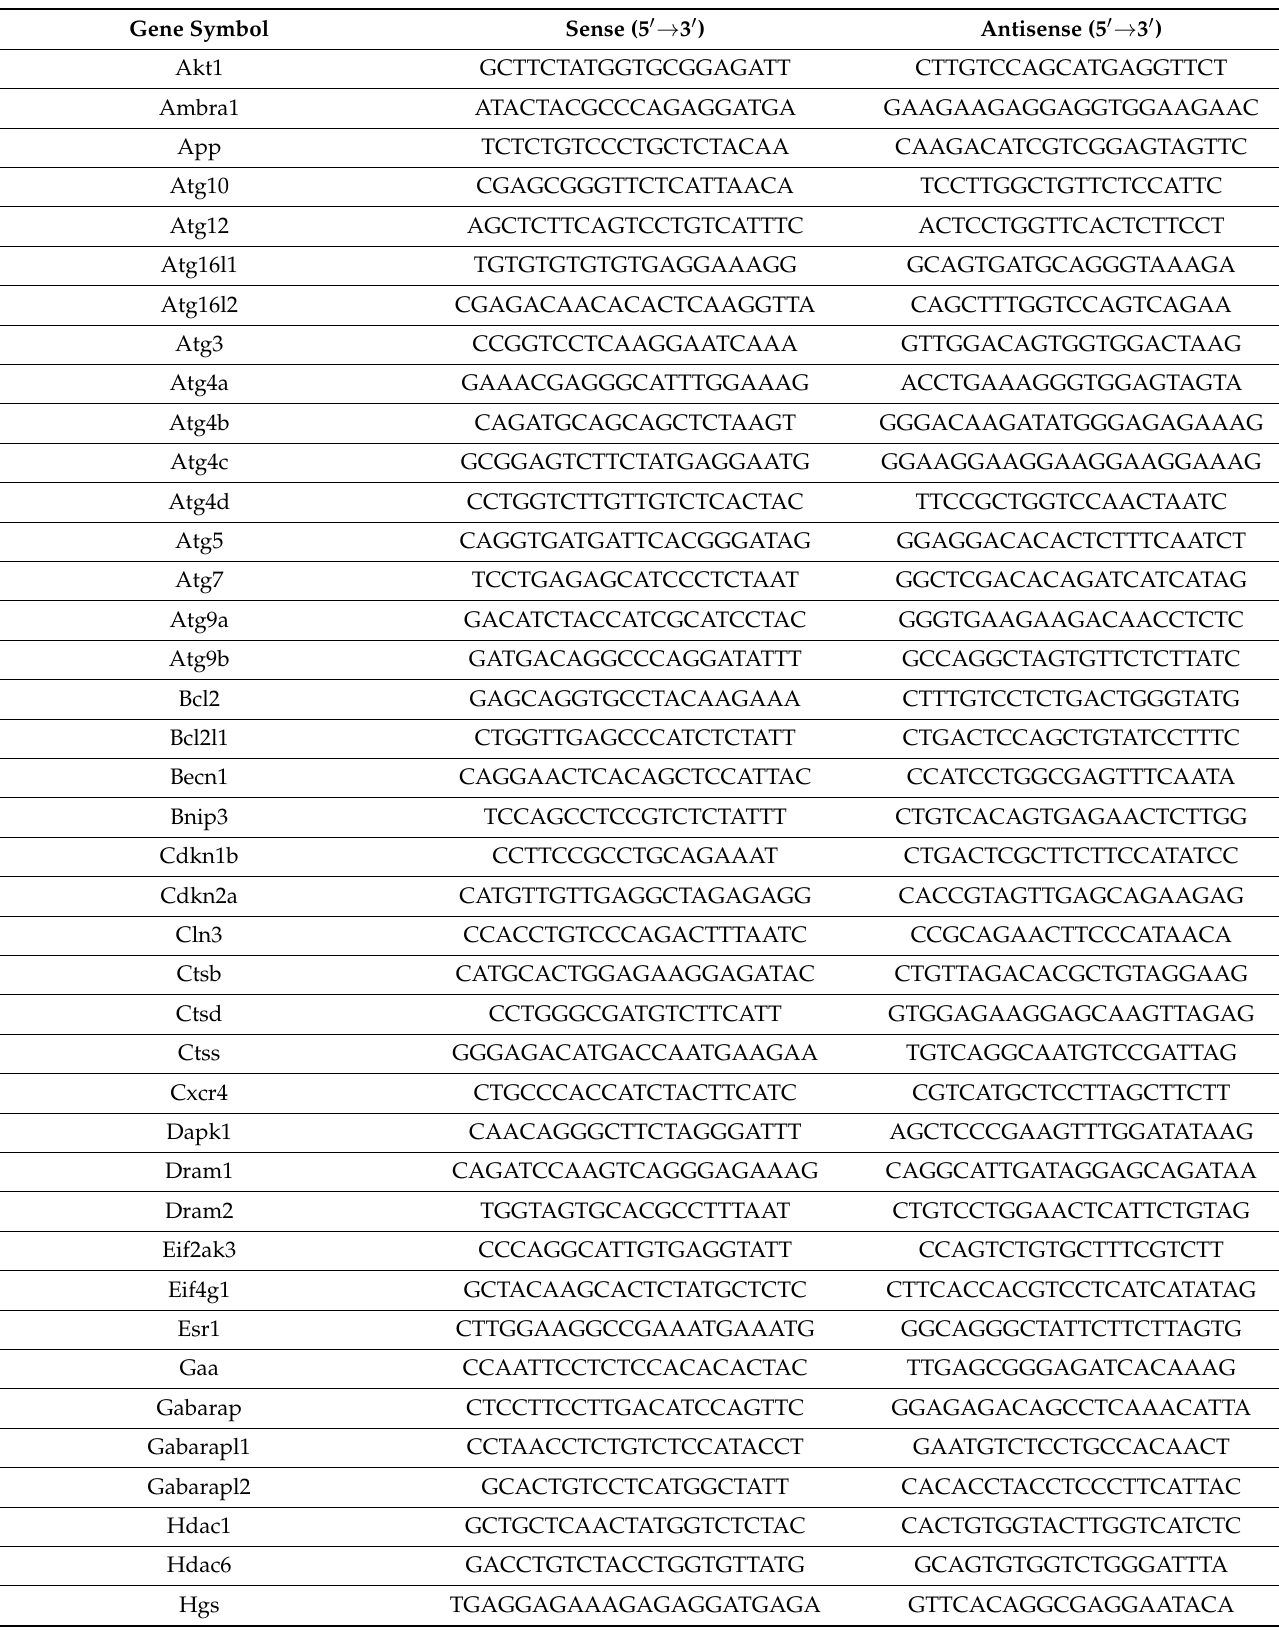
Table 1. Oligo sequences for PCR array of autophagy-related